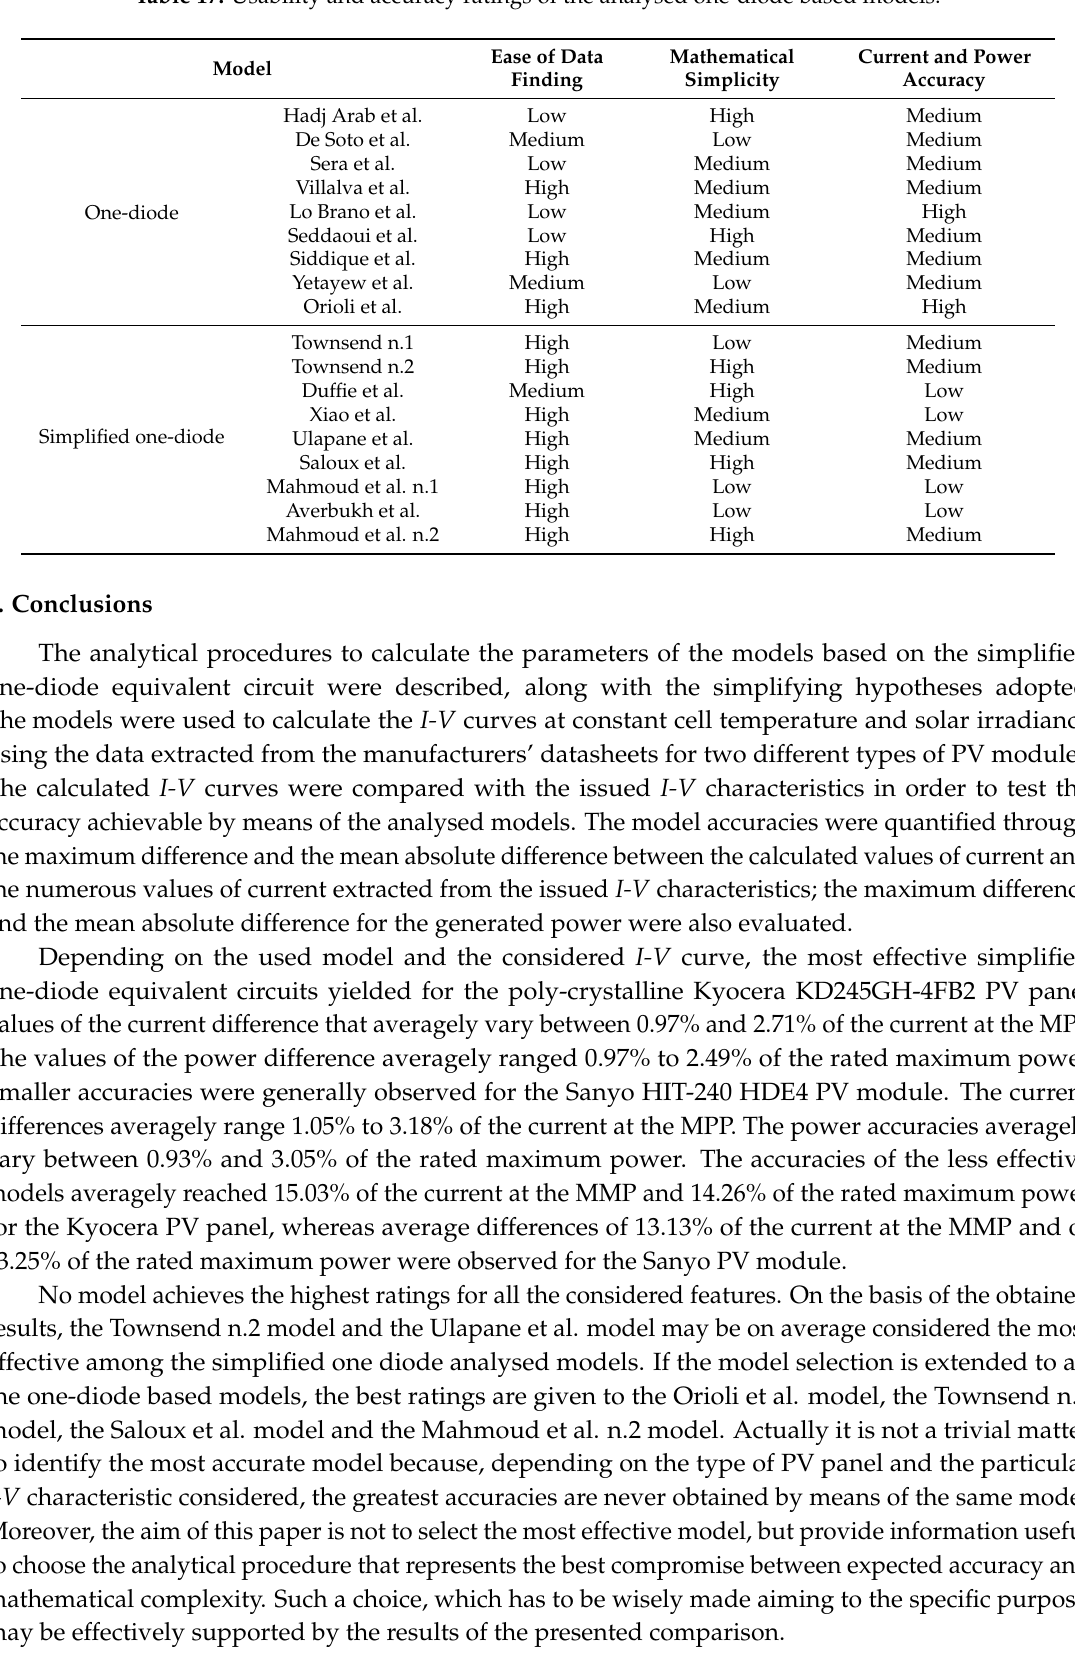
Table 17. Usability and accuracy ratings of the analysed one-diode based